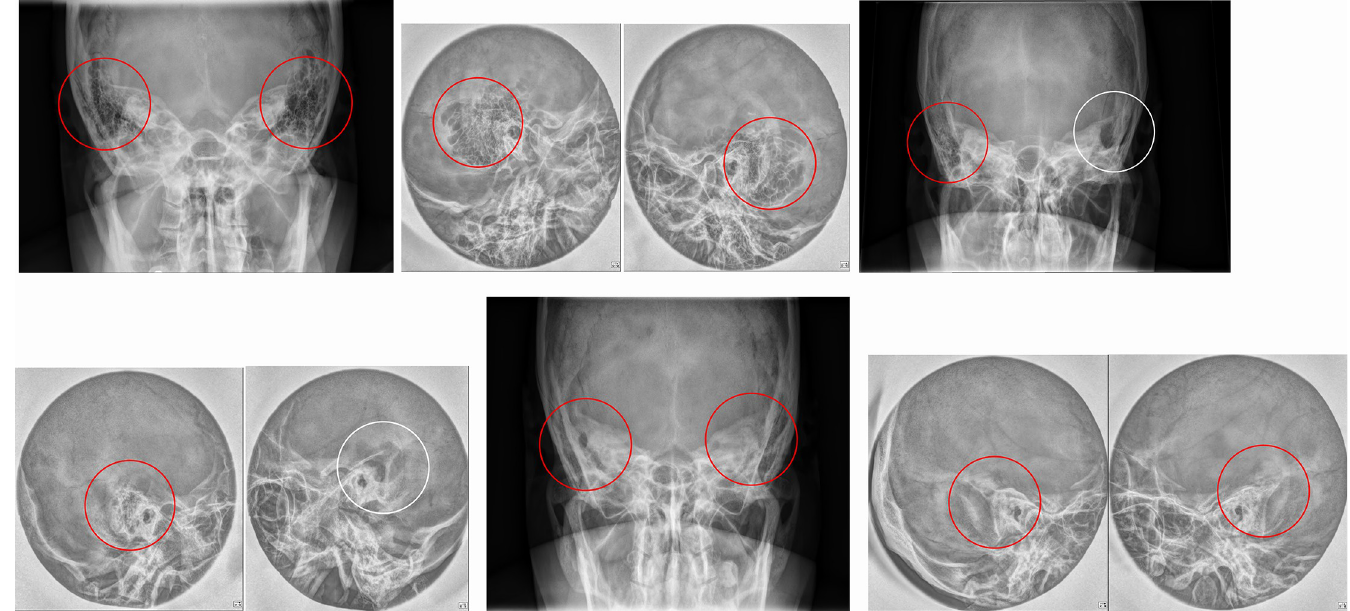
Fig 1. Typical images of each labeling category. (a,b) AP view (a) and lateral view (b) show bilateral, clear mastoid air cells (red circles) with honey combing pattern of category 0. (c,d) right ear (red circles) of AP view (c) and lateral view (d) shows slightly increased haziness in mastoid air cells suggesting category 1 and left ear (white circles) of both views shows bony defects with air cavities suggesting category 3. (e, f) AP view (e) and lateral view (f) show bilateral, total haziness and sclerosis of mastoid air cells (red circles) suggesting category